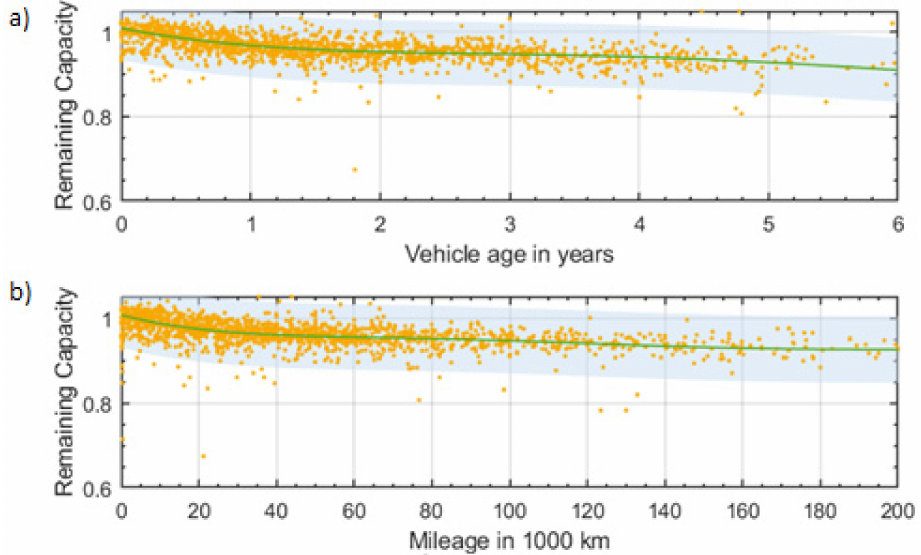
Figure 12. Maximal range survey from Tesla Motors, Netherlands forum with reported remaining capacity over: ( a ) years and ( b ) mileage from [166]. Each orange dot is one entrance and vehicles can have multiple entries within their life. The trendline is shown in green and 95% confidence interval in light